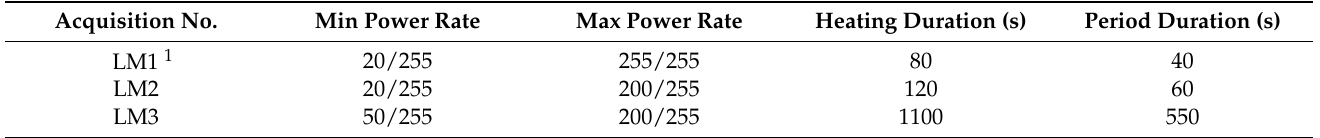
Table 6. Optical lock-in acquisition protocols applied to the monolithic CFRP sample.